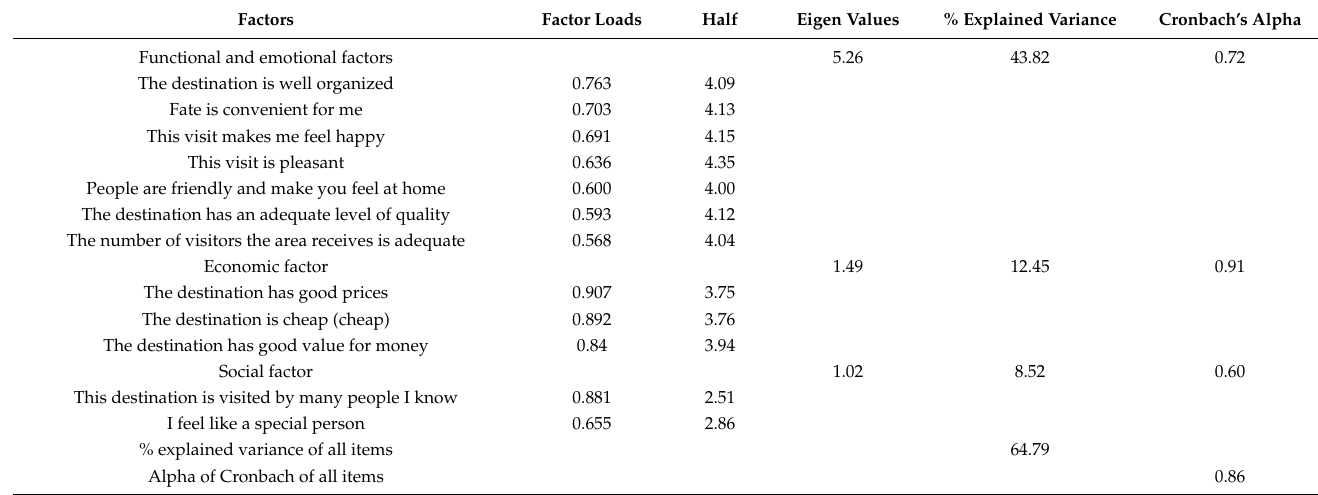
Table 1. Dimensions of perceived